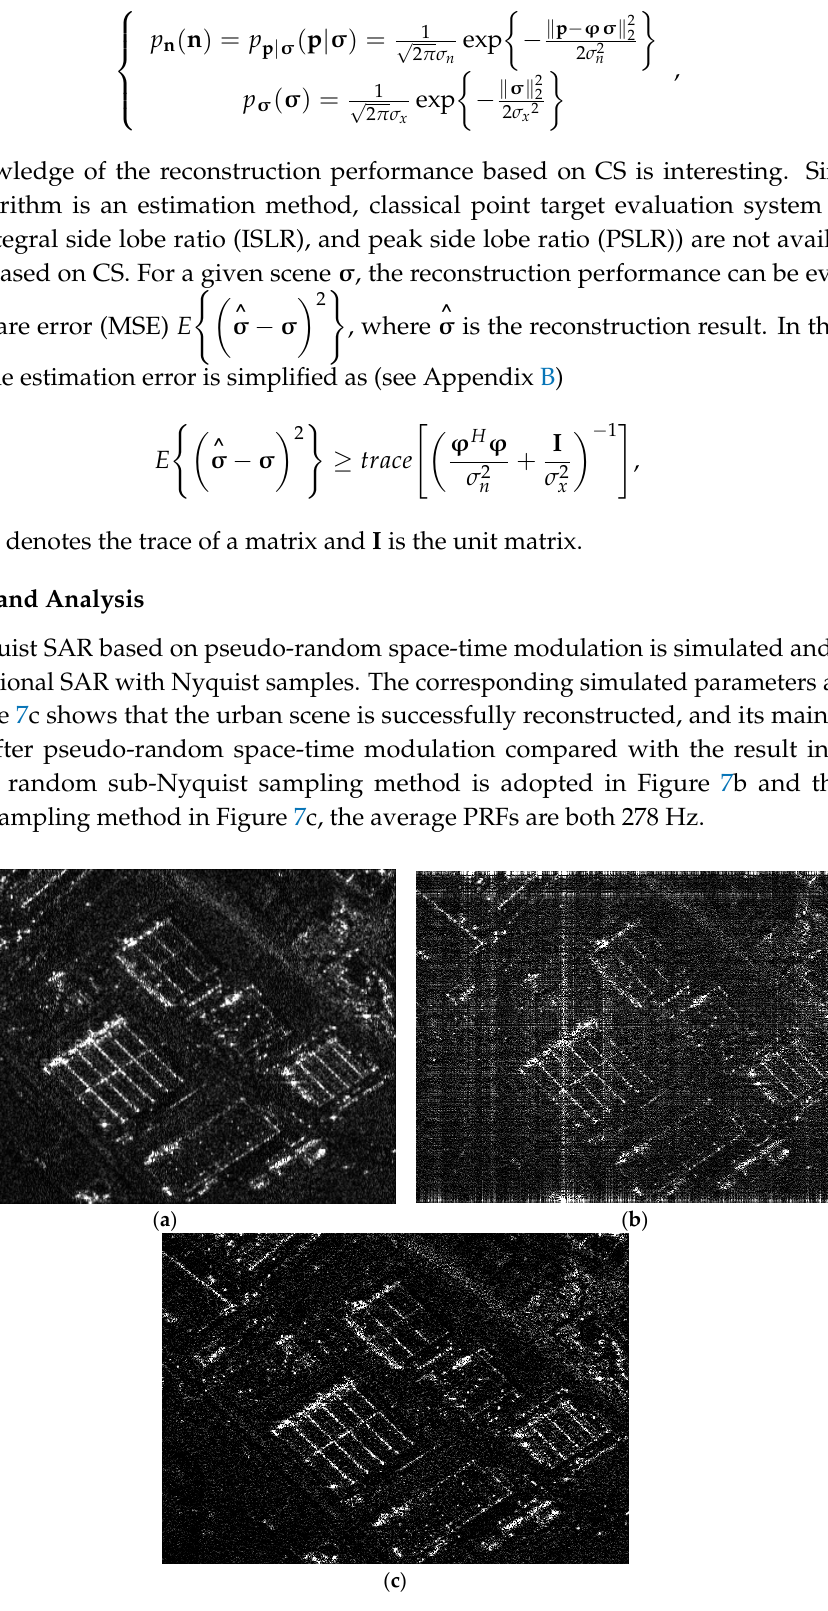
Figure 7. ( a ) Reconstructed result from Nyquist samples; ( b ) Reconstructed result from sub-Nyquist samples; ( c ) Reconstructed result from sub-Nyquist samples after the pseudo-random space-time